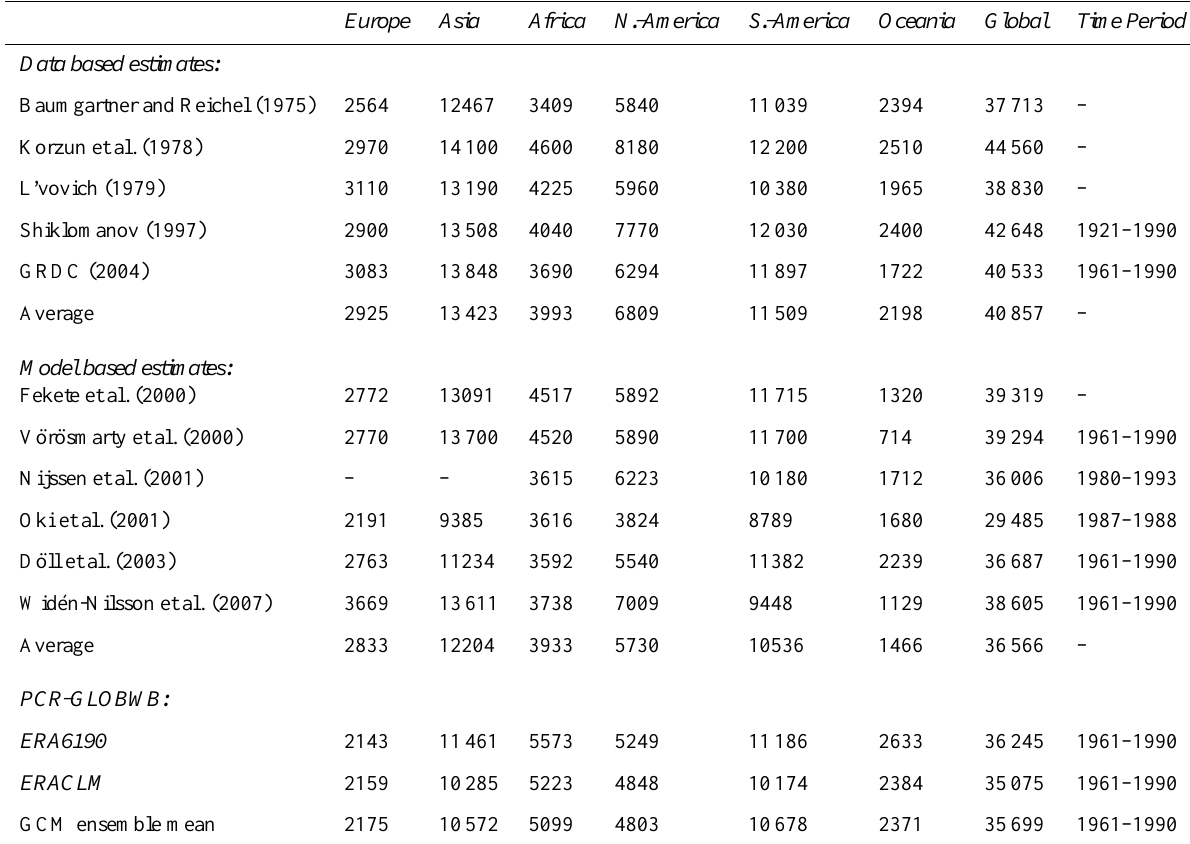
Table 3. Continental runoff based on data and model based estimates in km 3 /year (Wada et al.,